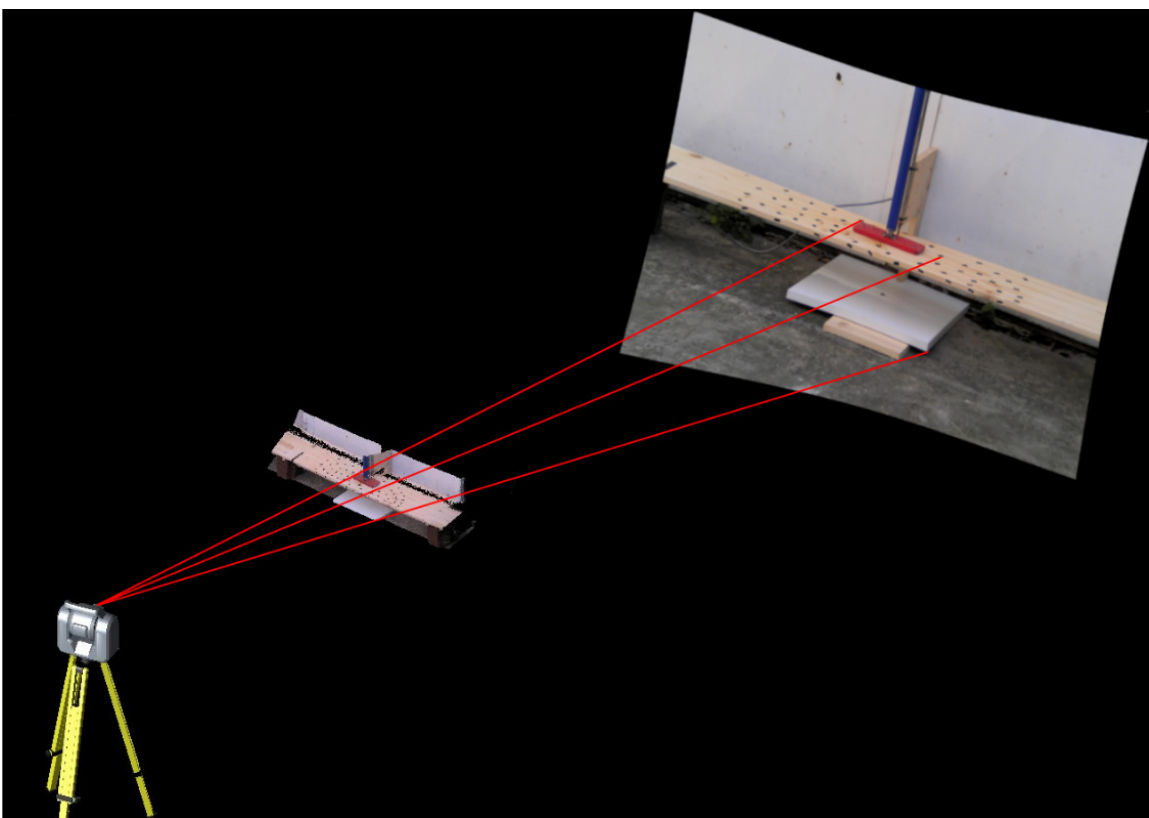
Figure 7. Spatial ray projection from the camera to the point cloud and image (Source: Own compilation).